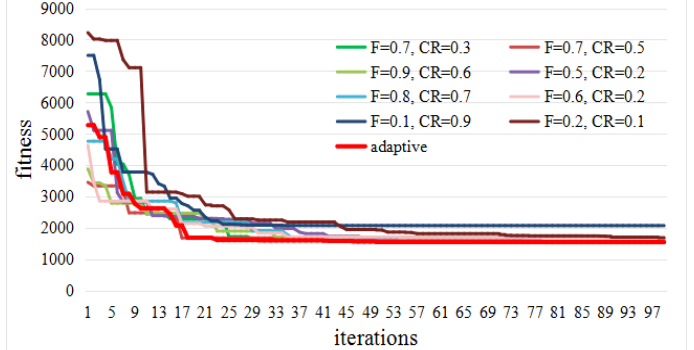
Figure 13. Relationship between the search performance (fitness) and different combinations of control parameters ( F and CR ).